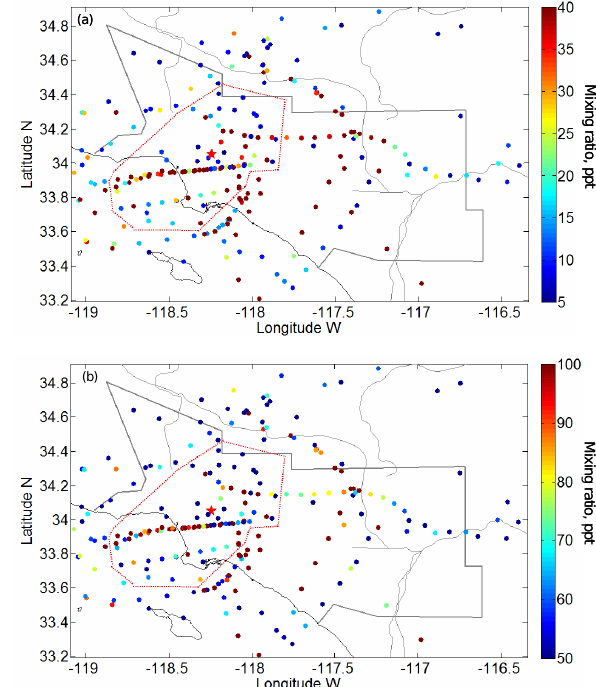
Fig. 6. Mixing ratios (ppt) of (a) HFC-152a and (b) HFC-134a measured over the SoCAB (boundary indicated by the solid gray line). The samples included within the red dotted line are the data points used to calculate emissions from the LA County. Downtown Los Angeles is indicated by the red